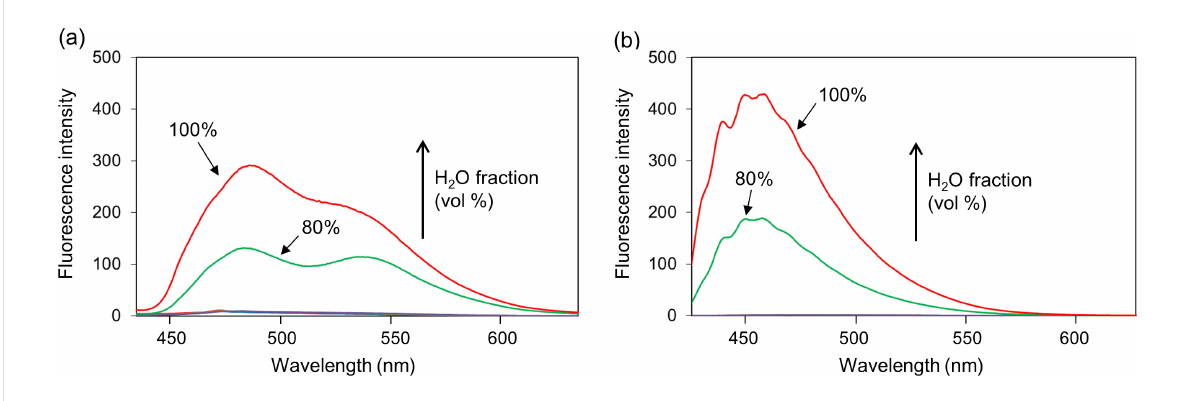
Figure 2: Fluorescence spectral profiles of (a) 4a (10 − 5 M, Ex max = 413 nm) and (b) 4e (10 − 5 M, Ex max = 415 nm) in H 2 O/EtOH mixture with different water fractions.